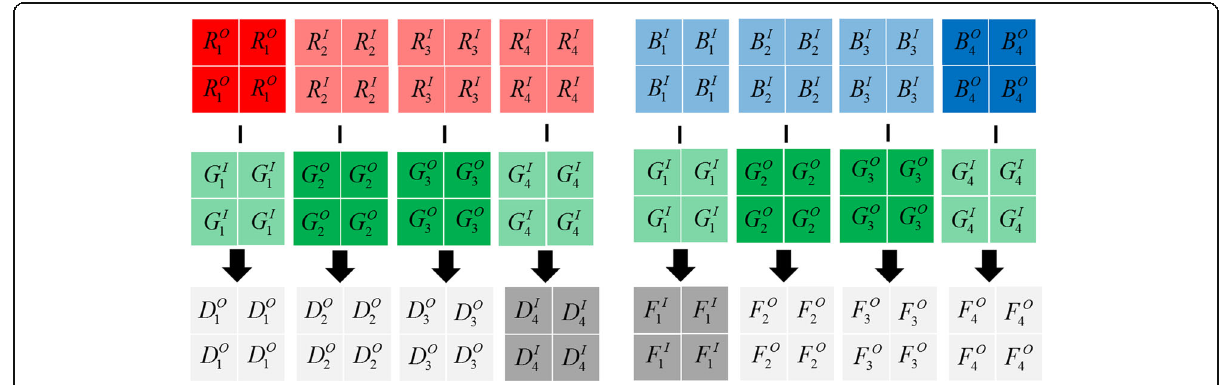
Fig. 5 Example of constructing color difference block for the RGGB Bayer CFA